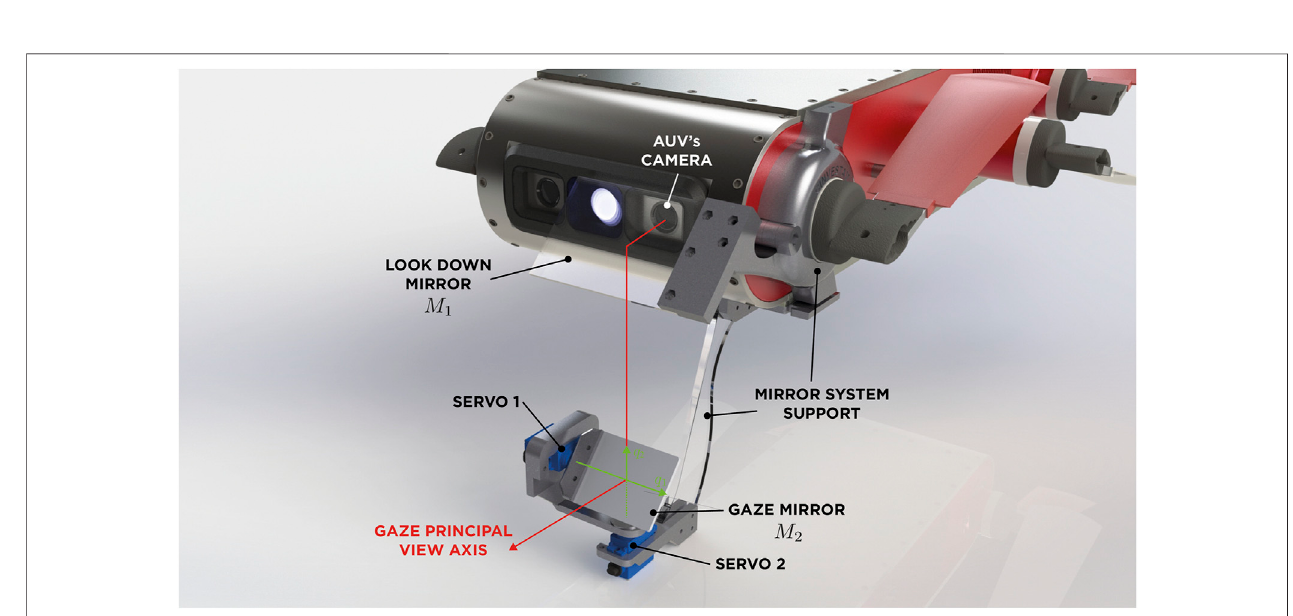
FIGURE 6 | Schematic diagram of the structure and degrees of freedom (DOFs) of the gazing mirror. q 1 moves the mirror in roll and q 2 in pitch .